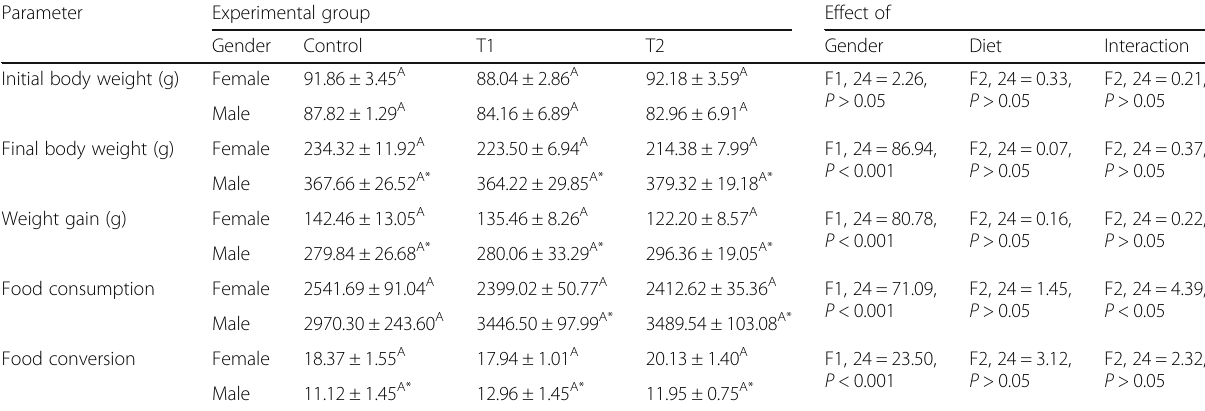
* Represent significant differences ( P <0.05) in comparison to the corresponding female groups. In each row, the mean values marked with the same superscript letter are similar (insignificant, P >0.05), whereas those with different ones are significantly differed ( P <0.05). P >0.05: insignificant, P <0.05, P <0.01 and P <0.001: significant effect at α =0.05, 0.01 and 0.001, respectively